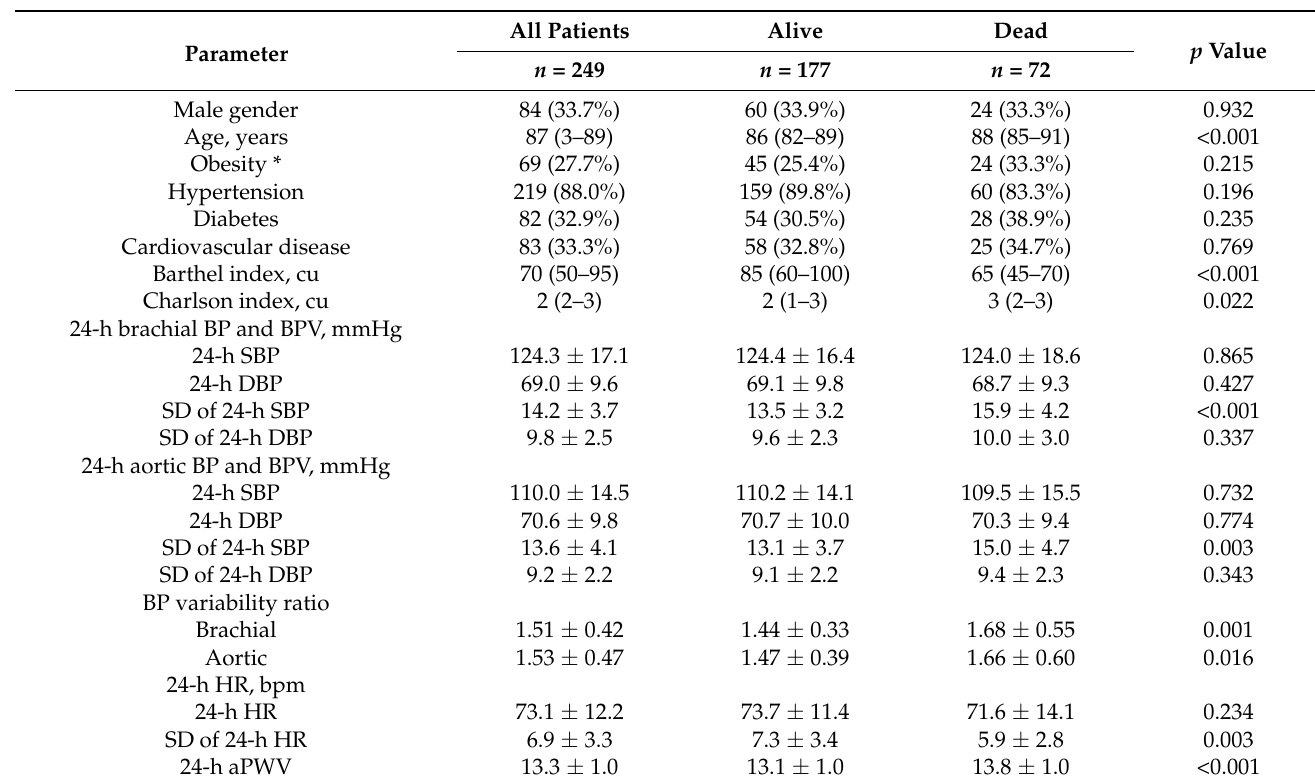
Table 1. Differences in clinical parameters, BP estimates, aortic pulse wave velocity (aPWV), and blood pressure variability (BPV) between patients who died or remained alive at 1-year